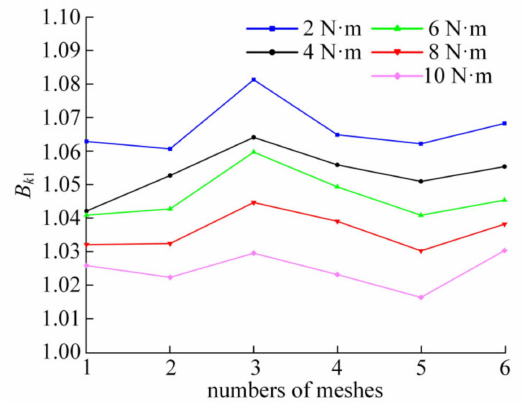
Figure 7. Load proportional coefficient curves under different load torques.